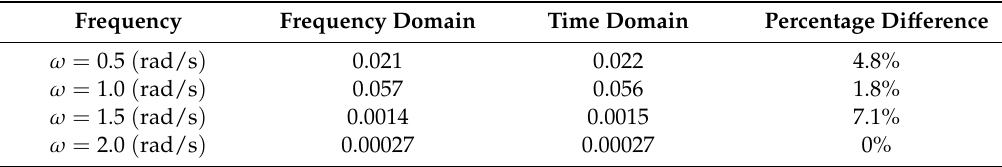
Table 3. The comparison between the capture width ratio results of the frequency domain and time